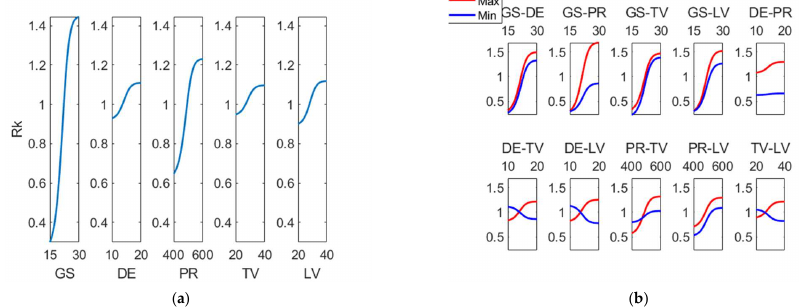
Figure 8. ( a ) Main effects plot and ( b ) interaction effects plot for (Rk ( µ m)).